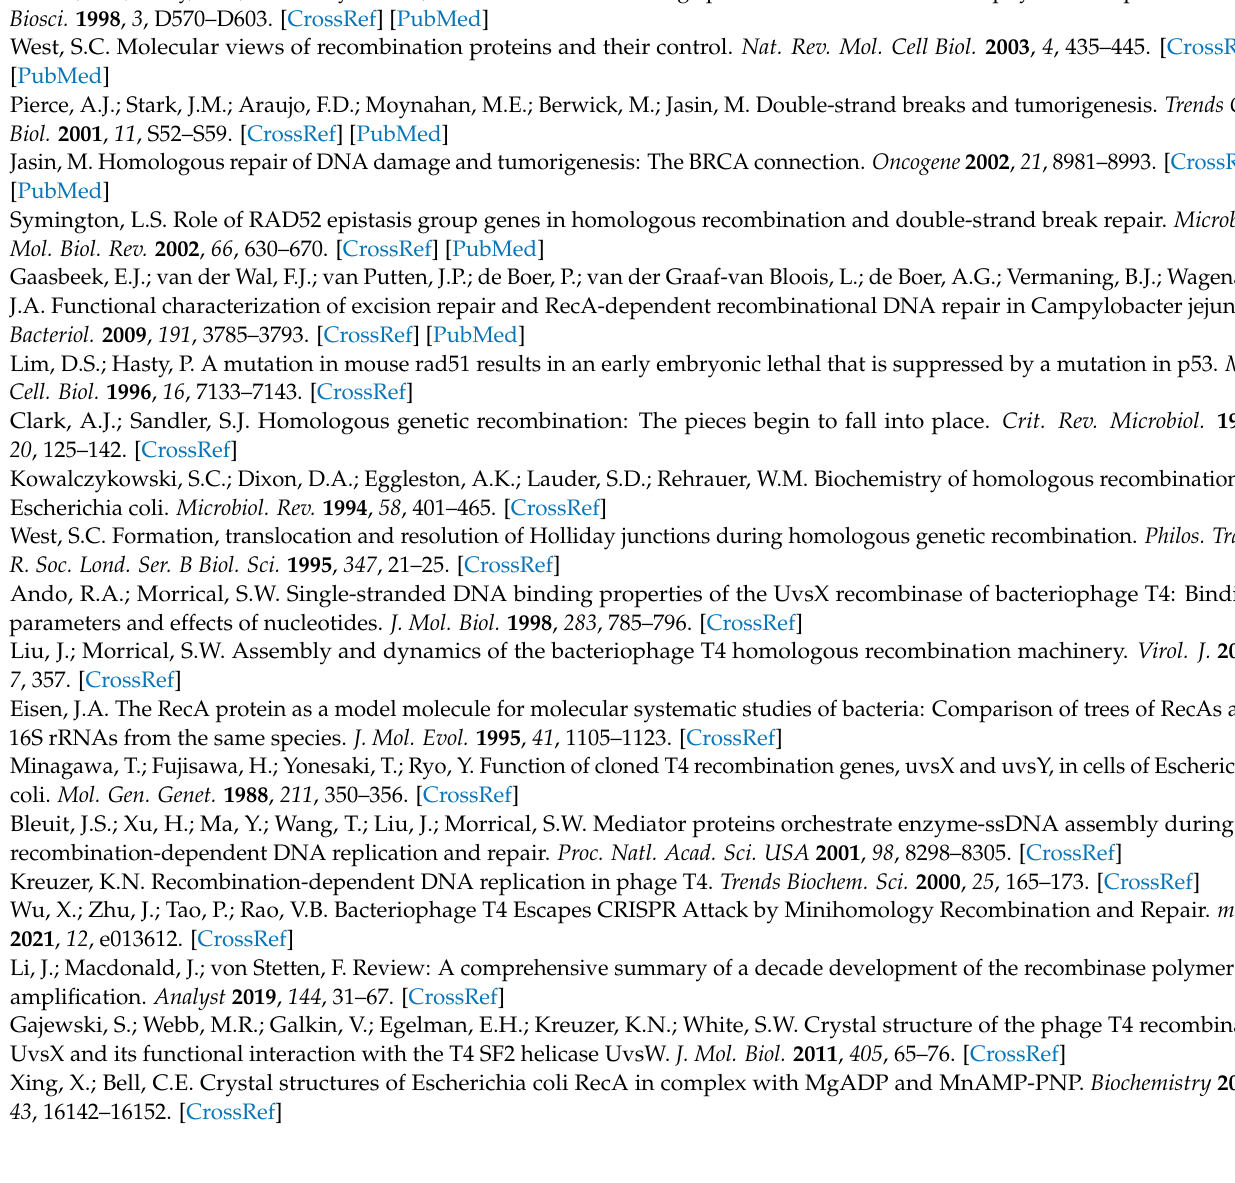
Figure S8: Number of nodes in the first five connected components at different cut-offs in RecA; Figure S9: Number of nodes in the first five connected components at different cut-offs in